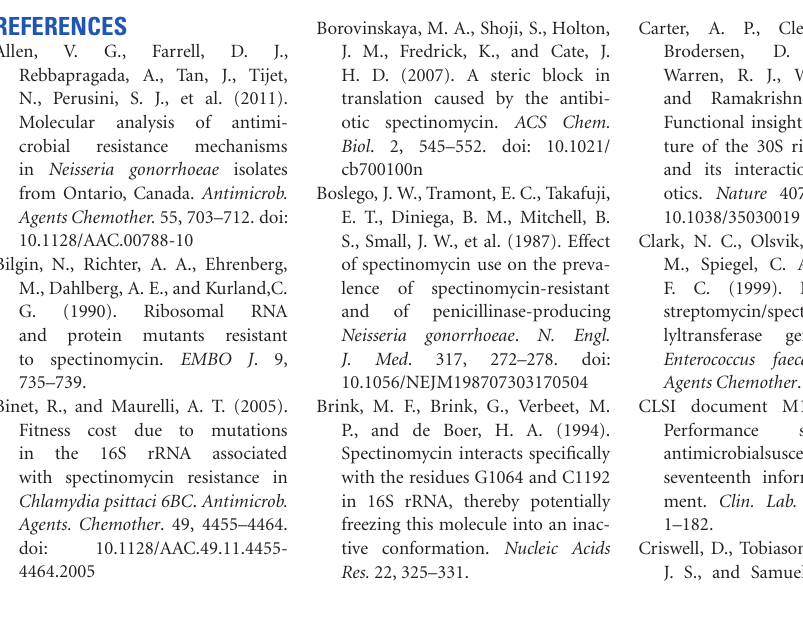
An average data from three replicas is